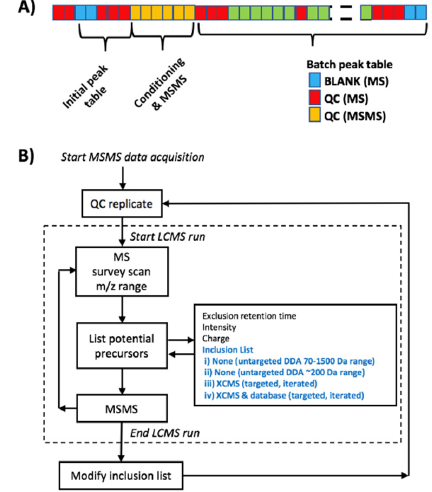
Figure 6. ( A ) Design of analytical batch integrating MS 2 DDA approaches within an untargeted metabolomics workflow. ( B ) MS 2 DDA approaches involving the use of QC replicates.